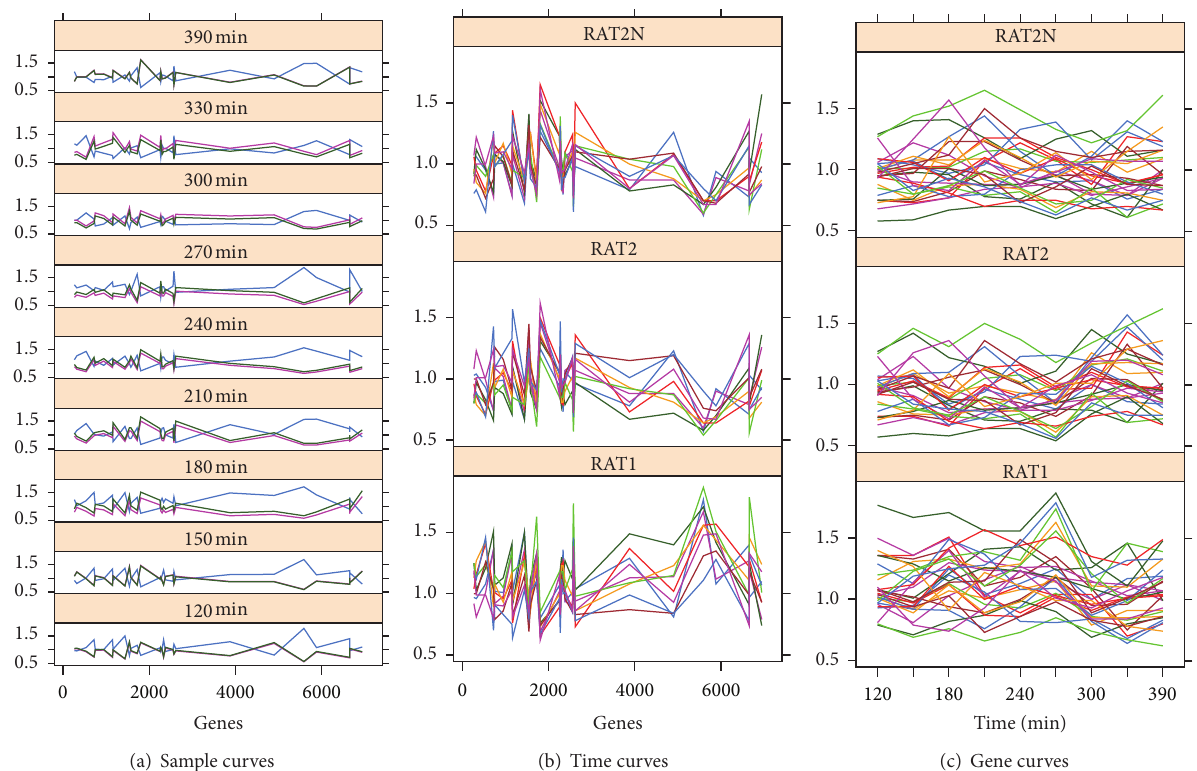
Figure 7: Graphical representation for tricluster TC 9 found in the Yeast Cell Cycle Dataset.